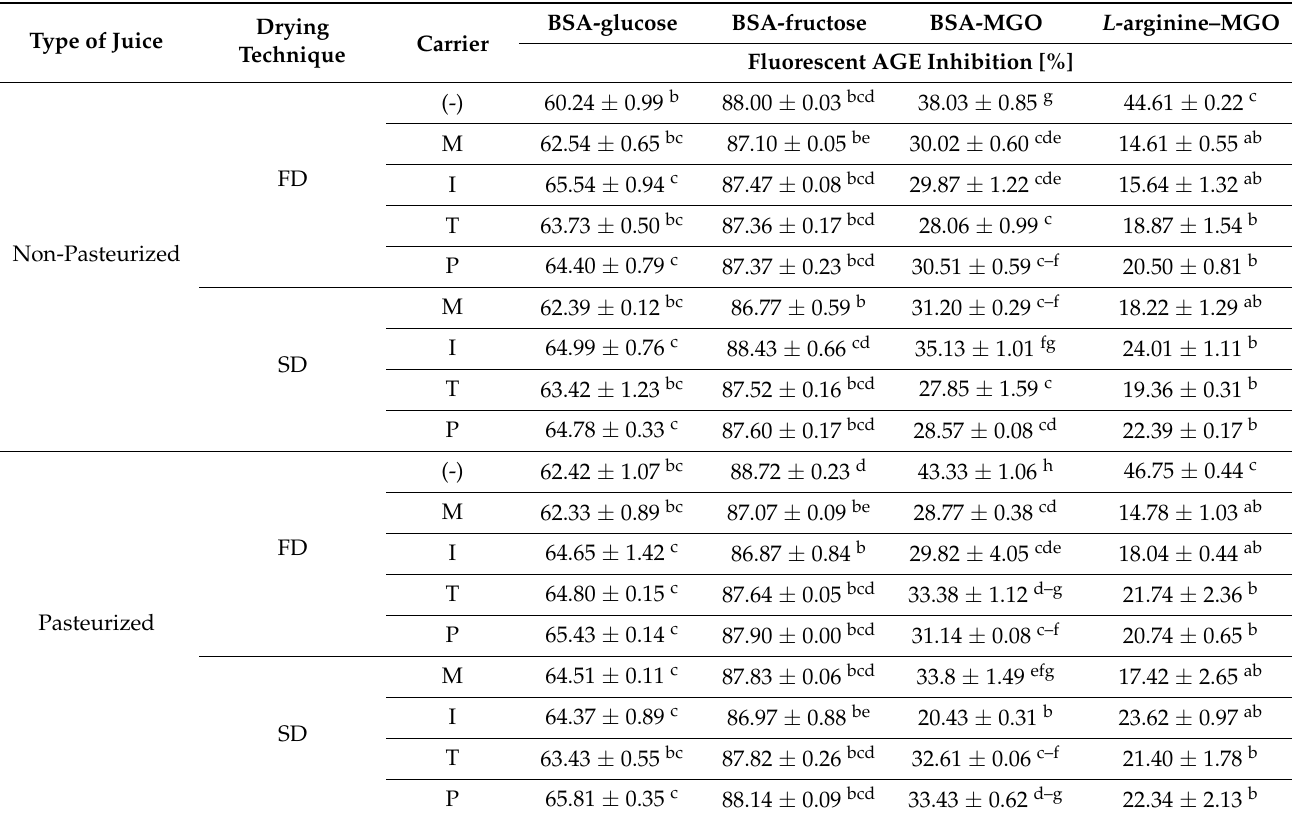
Table 5. Inhibitory effects of rosehip powders on AGE formation in BSA-glucose, BSA-fructose, BSA- methylglyoxal (BSA-MGO) and L -arginine–methylglyoxal model at 37 ◦ C for 7 days.